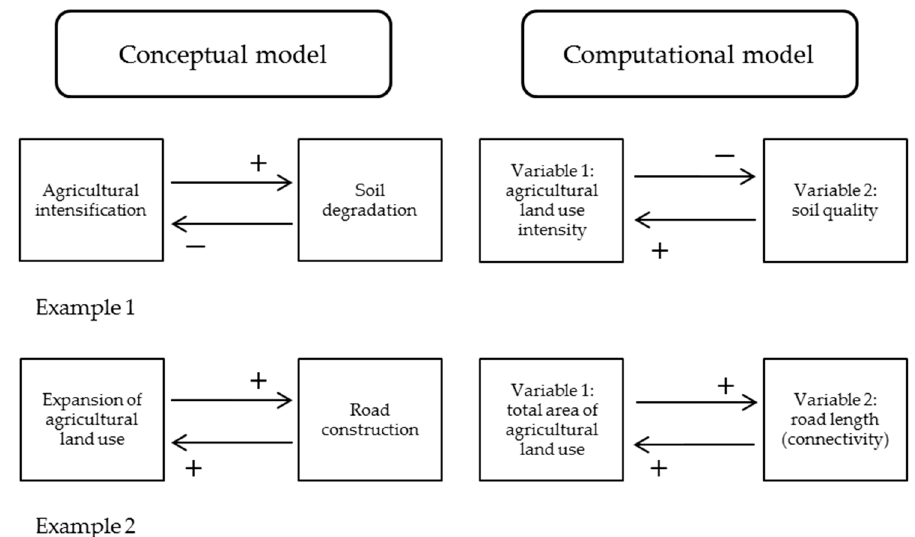
Figure 2. Examples of feedbacks in system conceptualisation and model implementation. Example 1: a negative feedback. ( Left ) Feedback between the process of agricultural intensification and the process of soil degradation. Intensification leads to soil degradation, which attenuates intensification. ( Right ) Implementation in computational model. Land use intensity and soil quality are the two linked variables that connect the sub-model of land use and the sub-model of soil. Increased land use intensity leads to reduced soil quality, which negatively feeds back to the intensity of agricultural land use. Example 2: a positive feedback. ( Left ) Feedback between the process of agricultural expansion and the process of road construction. They reinforce each other. ( Right ) Implementation in computational model. Total area of agricultural land use and road length are the two linked variables that connect the sub-model of land use and the sub-model of transport. Increased use of land leads to increased road construction at the expense of nature, which positively feeds back to the expansion of agricultural land use because of increased connectivity.